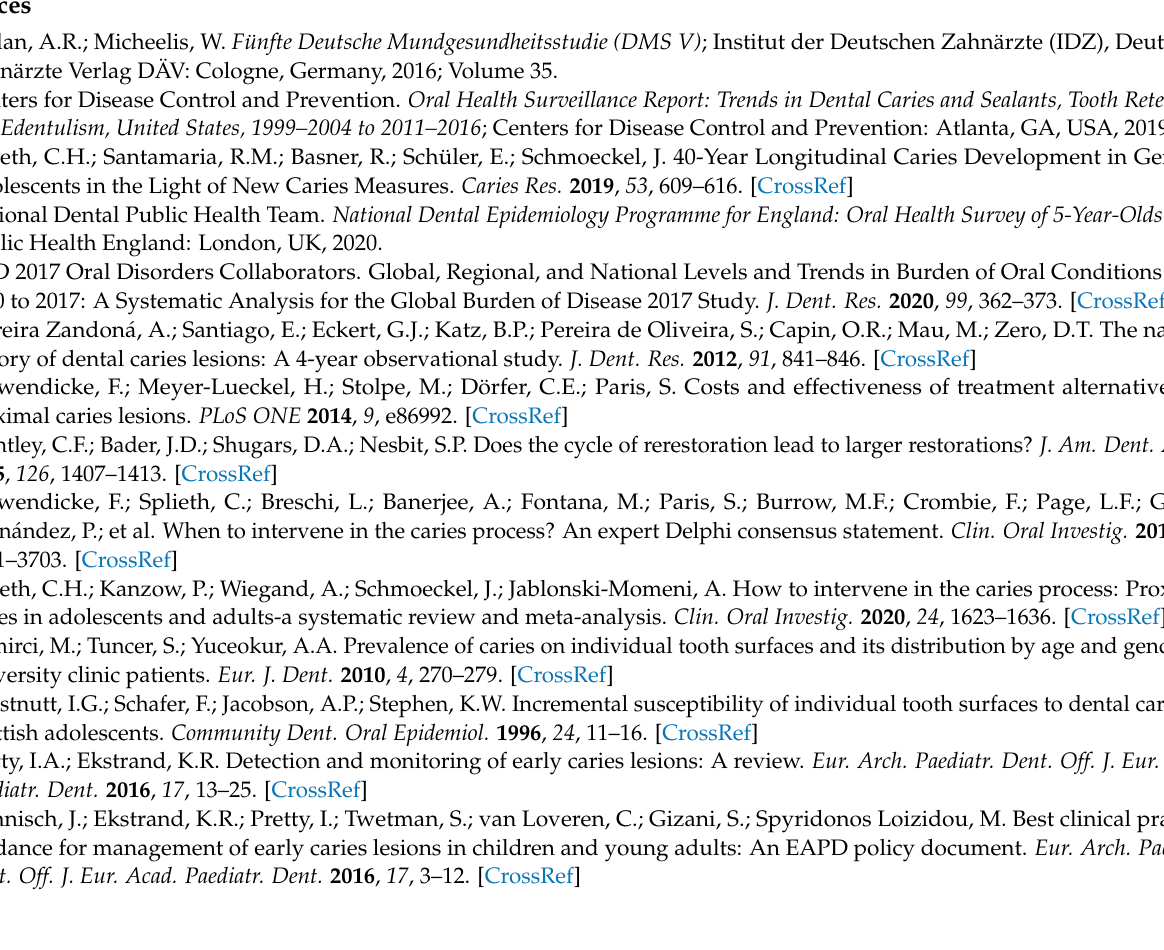
Table S2: Risk of bias of included studies; Figure S1: Funnel plot